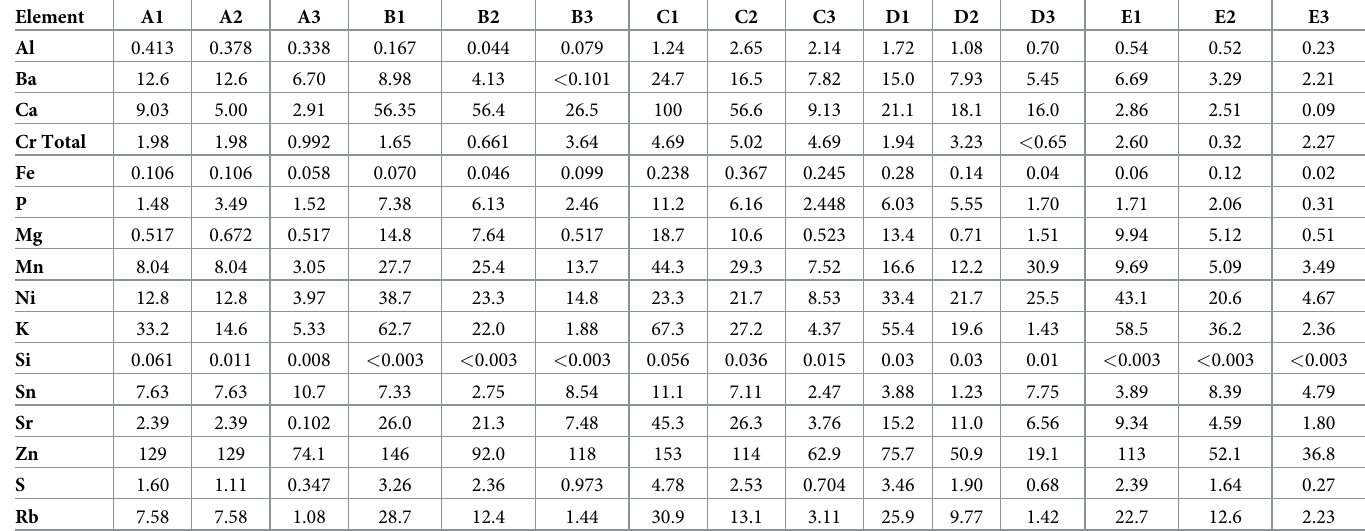
Table 4. Element % extraction (mean of three analyses) in three fractions (1, 2 and 3) of five different leachants in the percolation column test (A = MgCl 2 0,4 M; B =